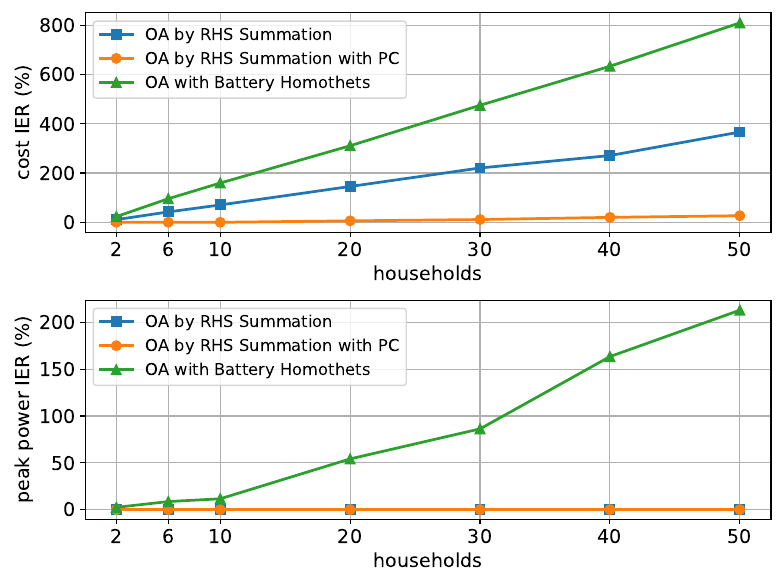
Figure 6. ( Top ): cost IER dependence on the number of households for 12 time periods; and ( bottom ): peak power dependence on number of households for 12 time periods.